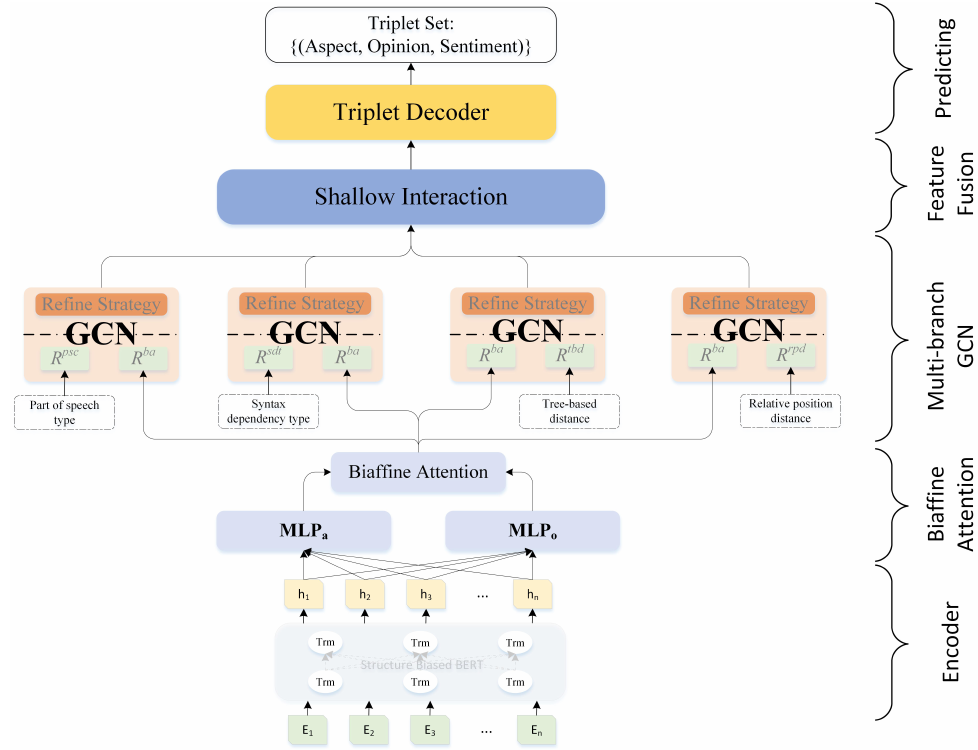
Figure 2. The overall framework of the proposed Multi-branched Graph Convolutional Network